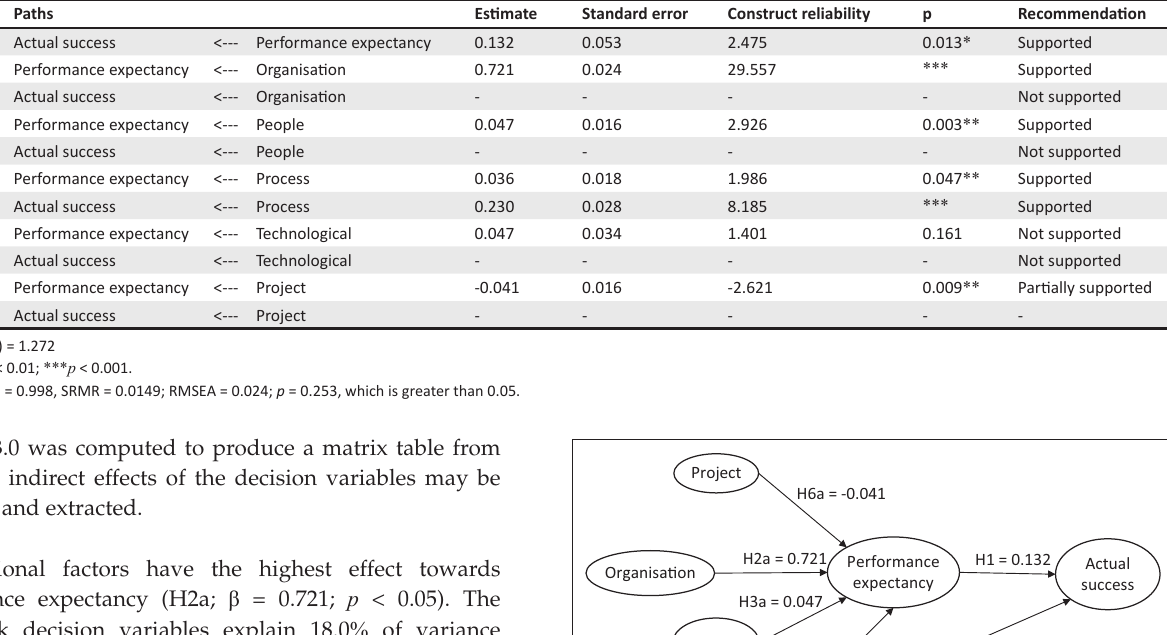
TABLE 4: Extracted standardised significance levels of the structural model.